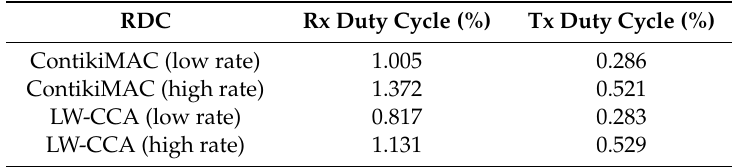
Table 9. Average of Rx and Tx duty cycles